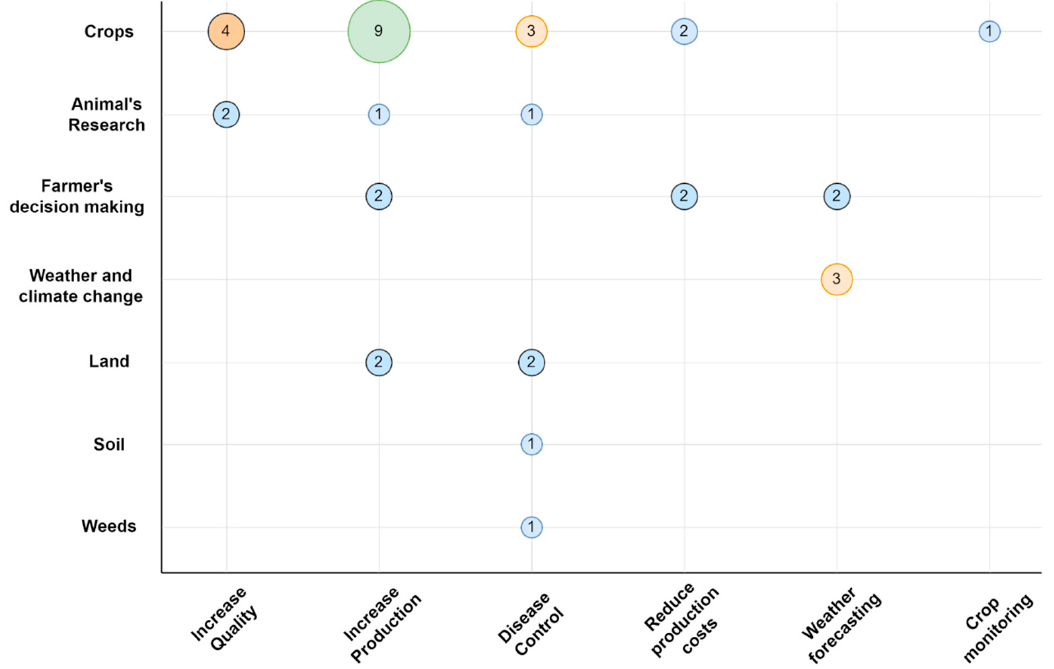
Figure 11. Main problems to be solved vs. agriculture.